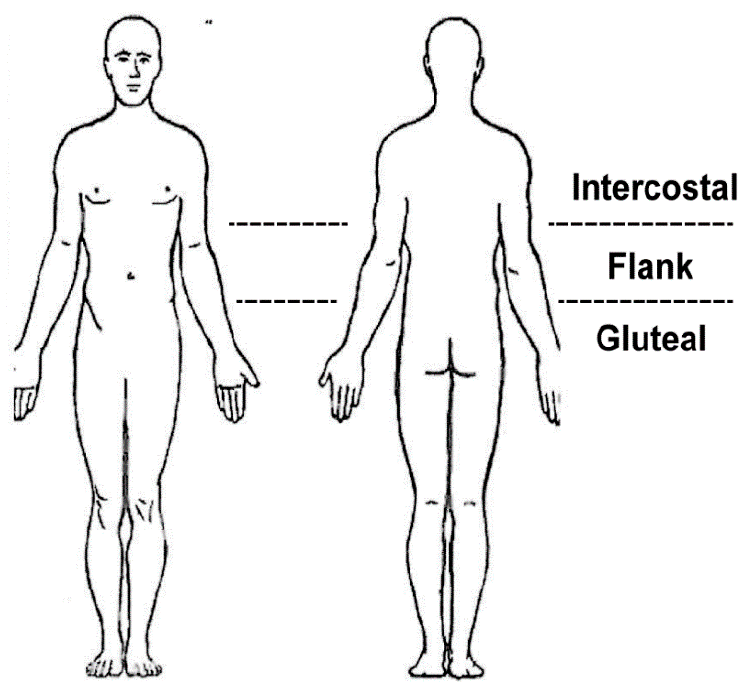
Figure 2. Illustration of patient-drawn pain locations on the human figure, divided into intercostal, flank (12th rib to iliac bone), and gluteal areas.